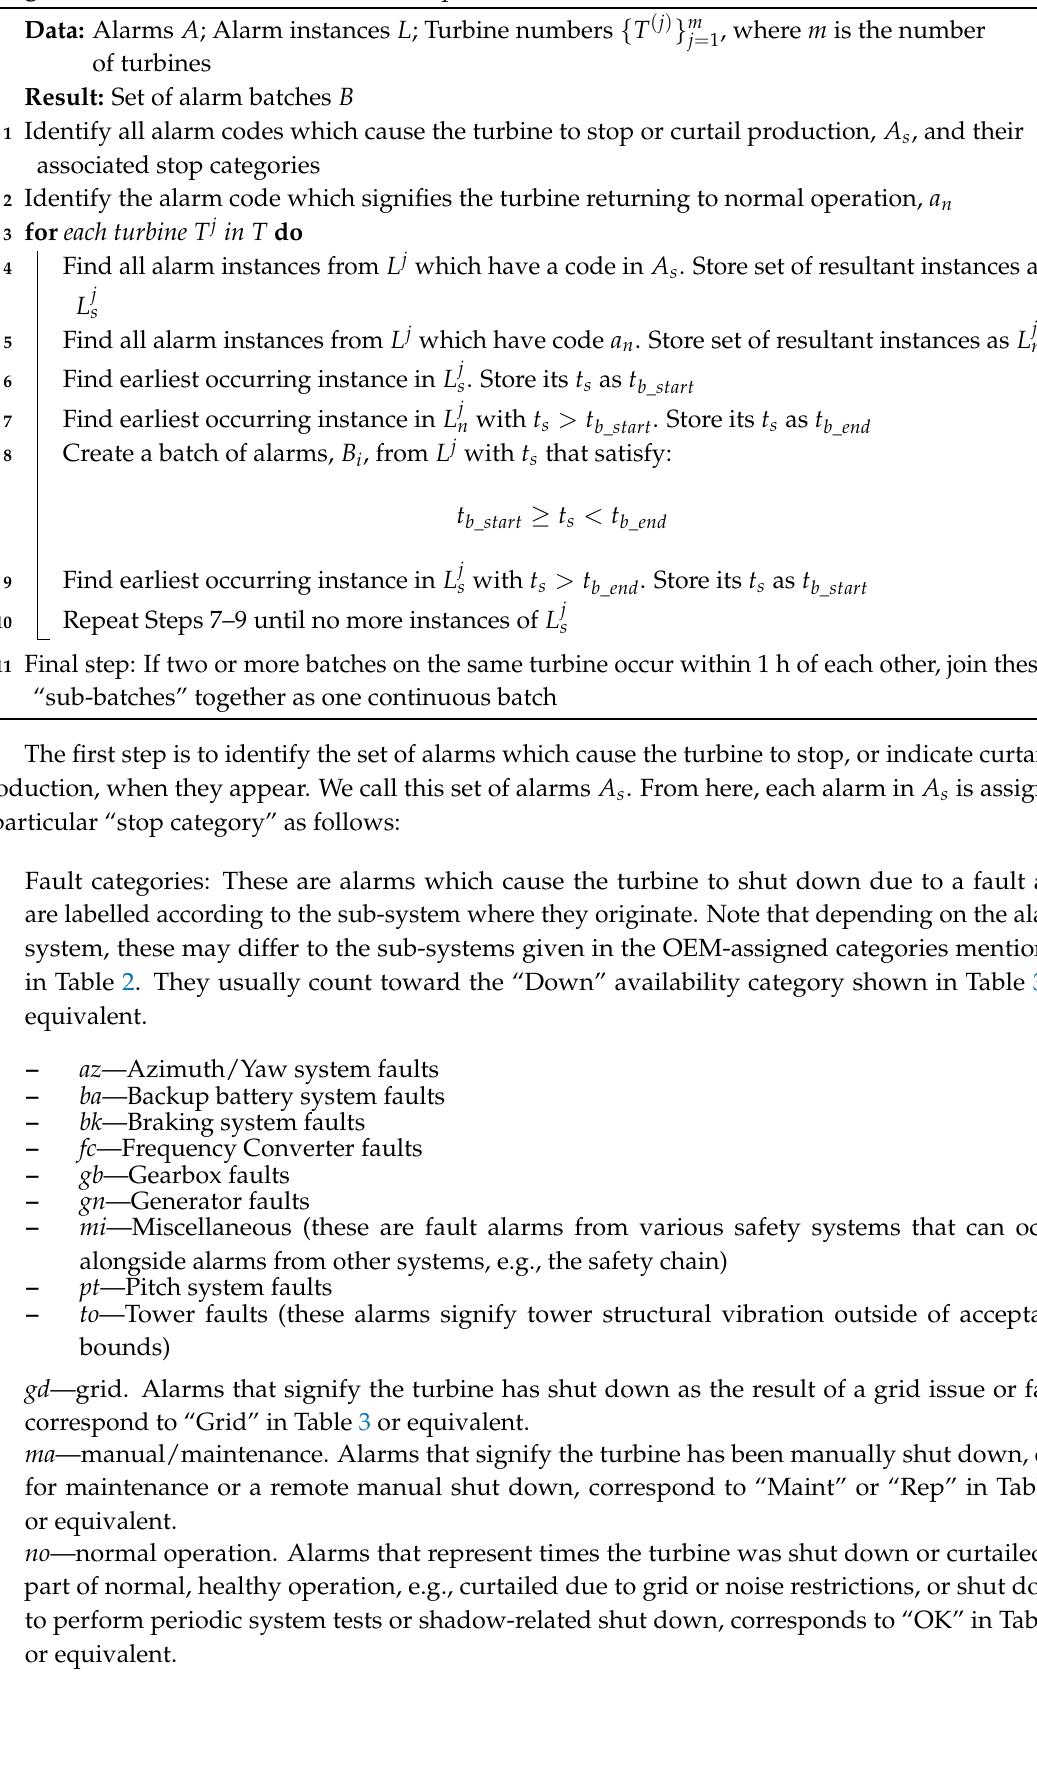
Algorithm 1: Create batches of alarm